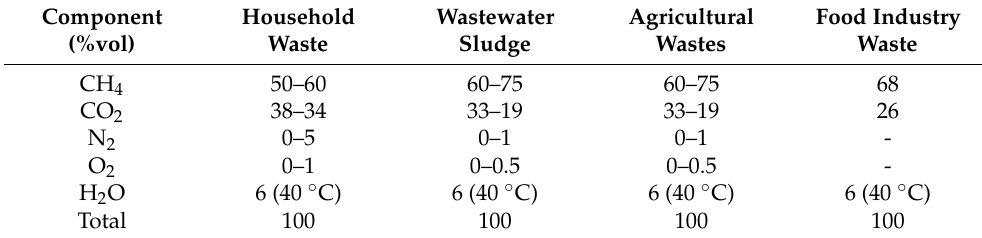
Table 2. Composition of Biogas from Different Types of